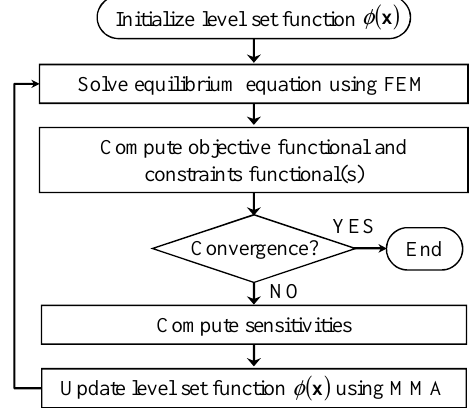
Figure 1. Optimization